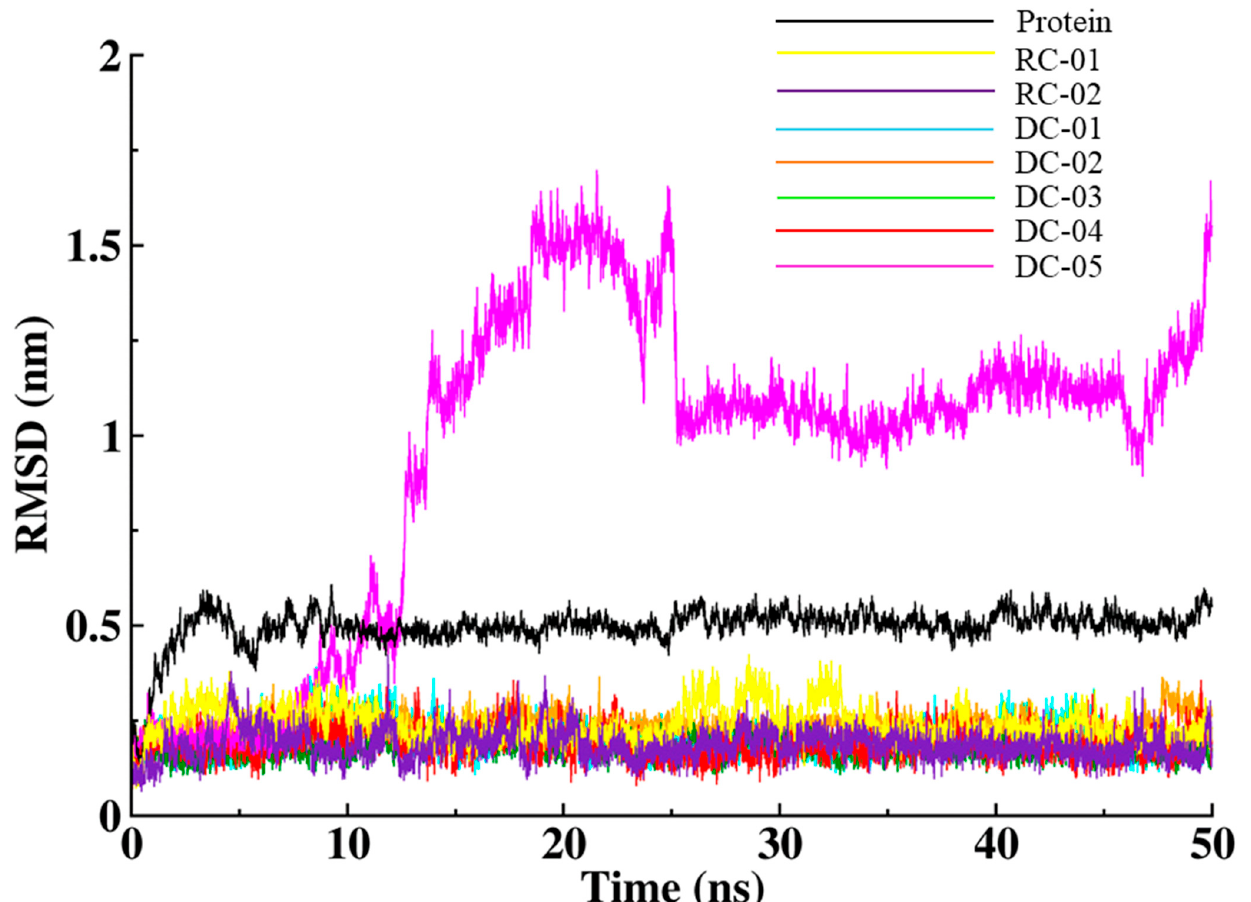
Figure 4. The overall RMSD analysis of protein and ligands compounds for 50 ns.